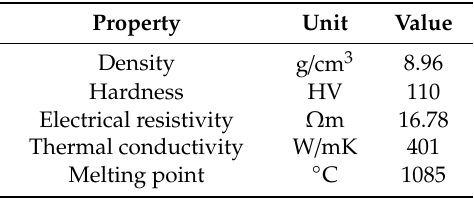
Table 1. Thermo-physical properties of copper.